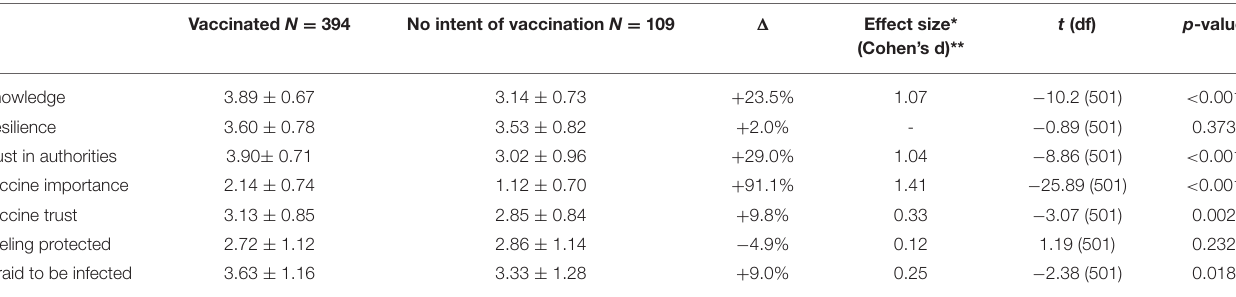
TABLE 3 | Differences in attitudes between those vaccinated/scheduled to be vaccinated vs. not vaccinated (T1).